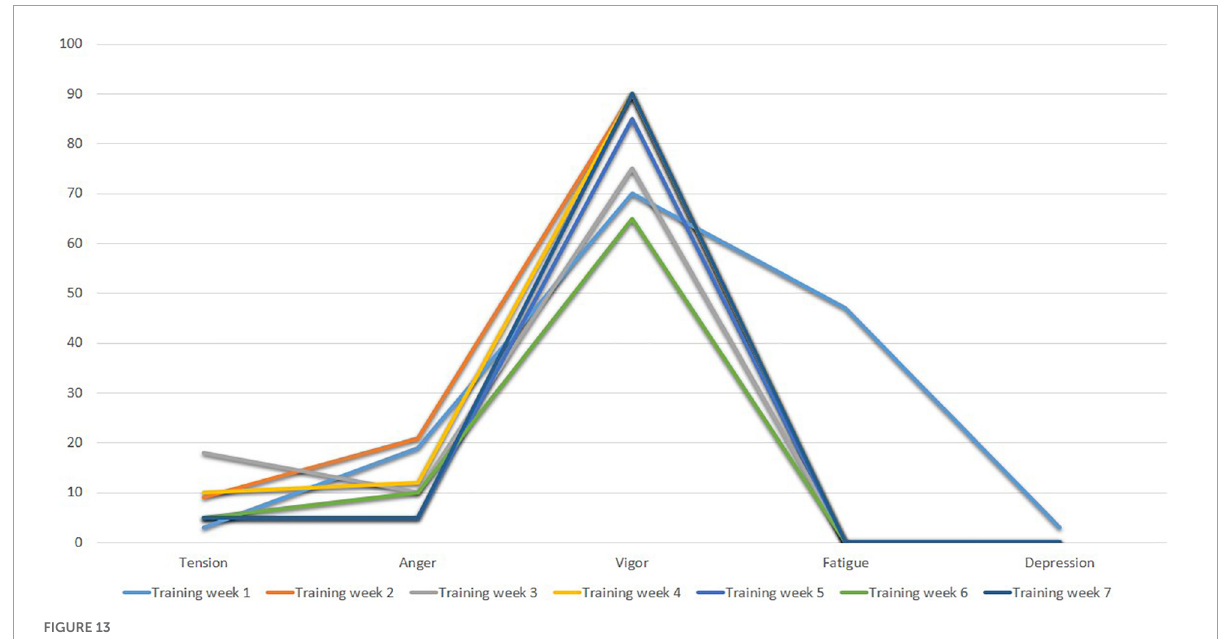
FIGURE13 POMS profiles of subject 4 after training